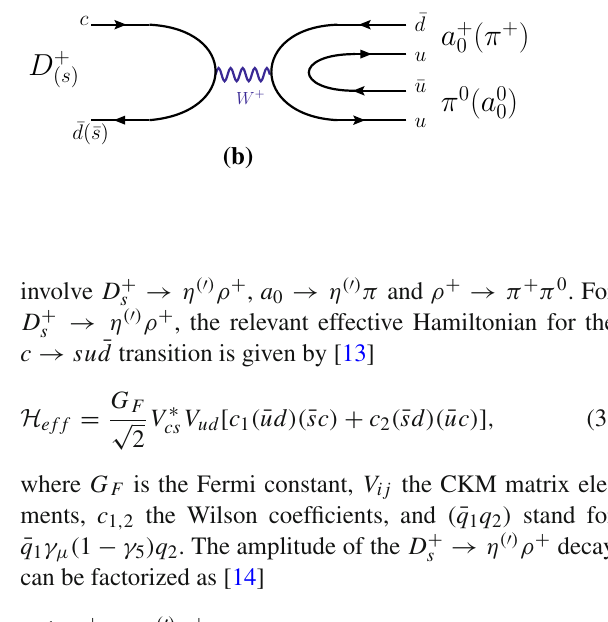
B ( D + → π + f ( 980 )) ∼ O ( 10 − 2 ) [10], suggesting 0 s